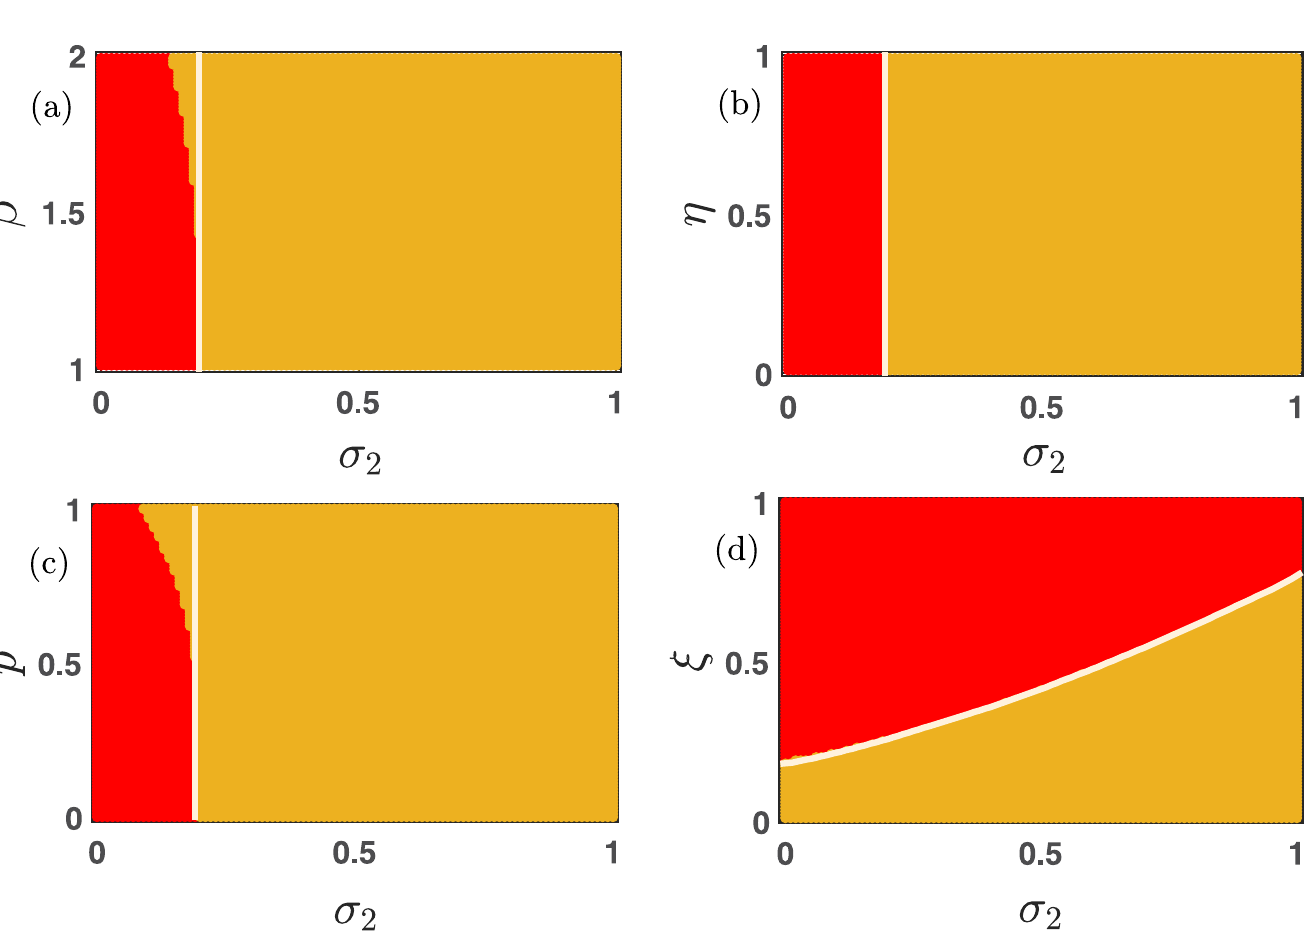
Fig 7. The impact of free space-induced benefits on the defectors in the presence of the mutation. Either all populations die (red region), or the symmetric mutation preserves the coexistence state (yellow area) in all these subfigures. Beyond a critical value of σ 2 , both strategies mutate one into another, providing the opportunities for the coexistence of both species. The solid white line is the analytically derived stability curve to stabilize the extinction equilibrium. All the parameters are kept fixed at ξ = 0.25, η = 0.85, p = 0.30, σ 1 = 0.30, μ = 0.5, β = 1.1, unless they are varied. The initial condition is kept fixed at (0.35, 0.35). The slight mismatch of the stability of the extinction equilibrium (0, 0) in subfigures (a) and (c) is due to the multistable dynamics of our proposed model